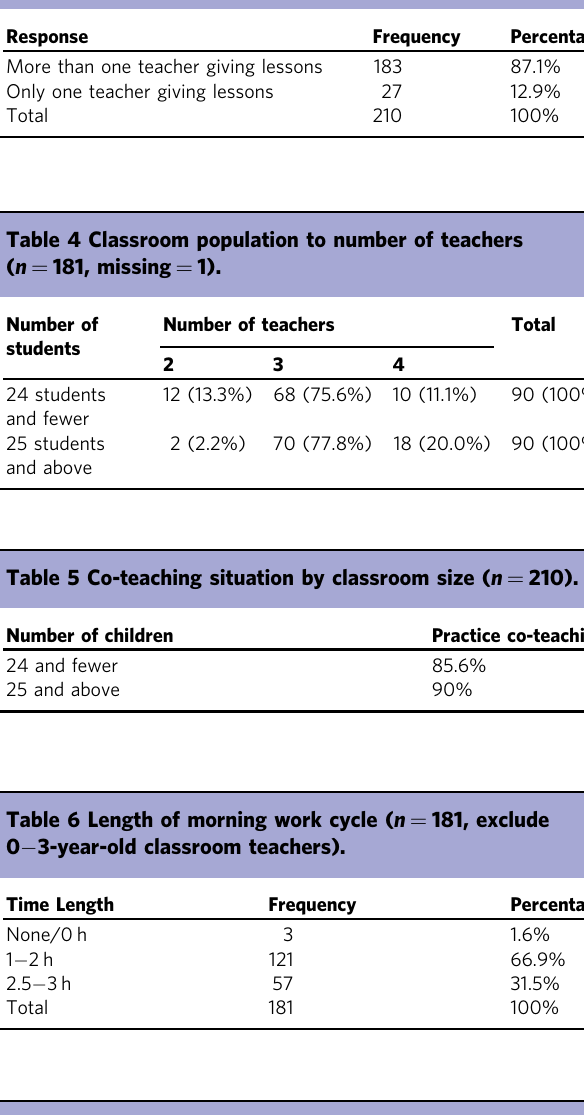
Table 7 Afternoon work cycle ( n = 210).